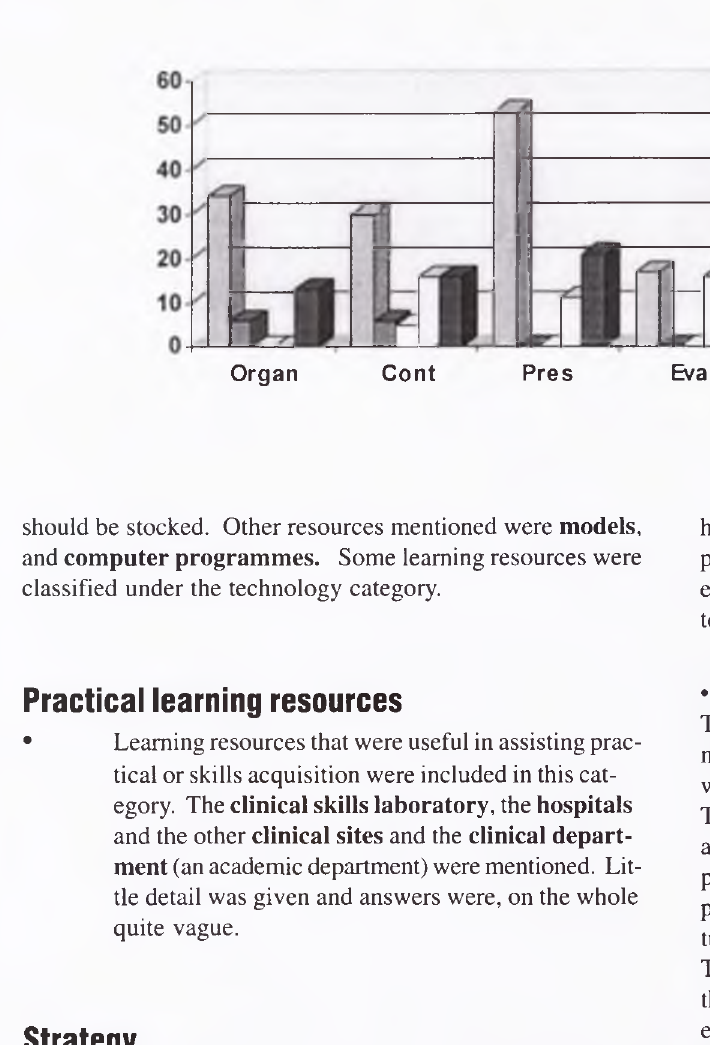
Figure 3: A comparison of educational